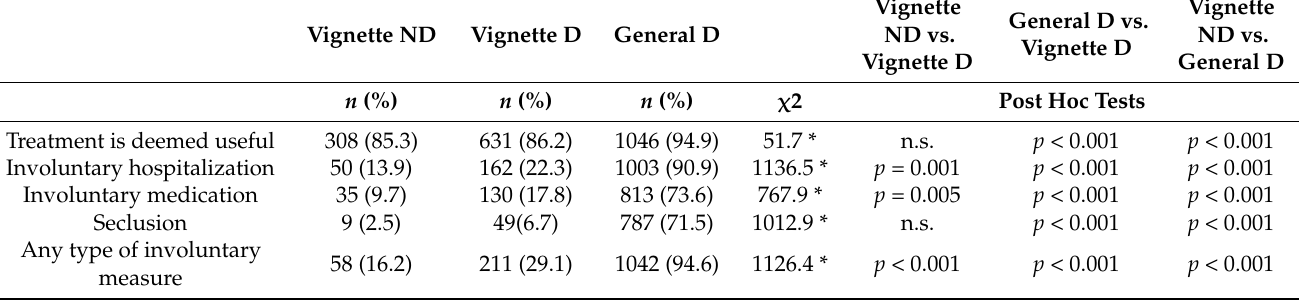
Table 3. Usefulness of psychiatric treatment and approval of involuntary